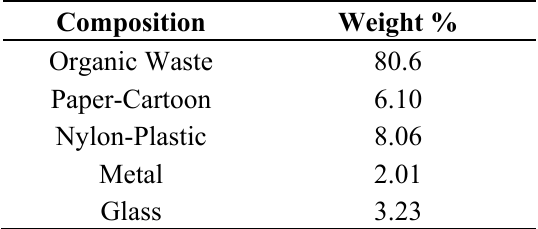
Table 2. Physical composition of the solid waste samples